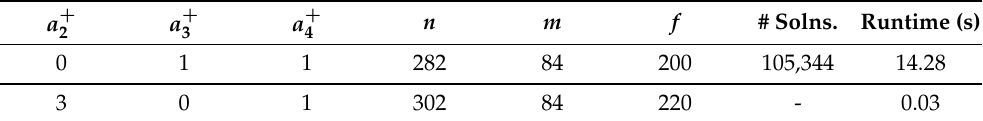
Table 5. Number of tiling solutions (# solns.) and runtimes in seconds for CPLEX to solve the two pariomino tiling subproblems in Example